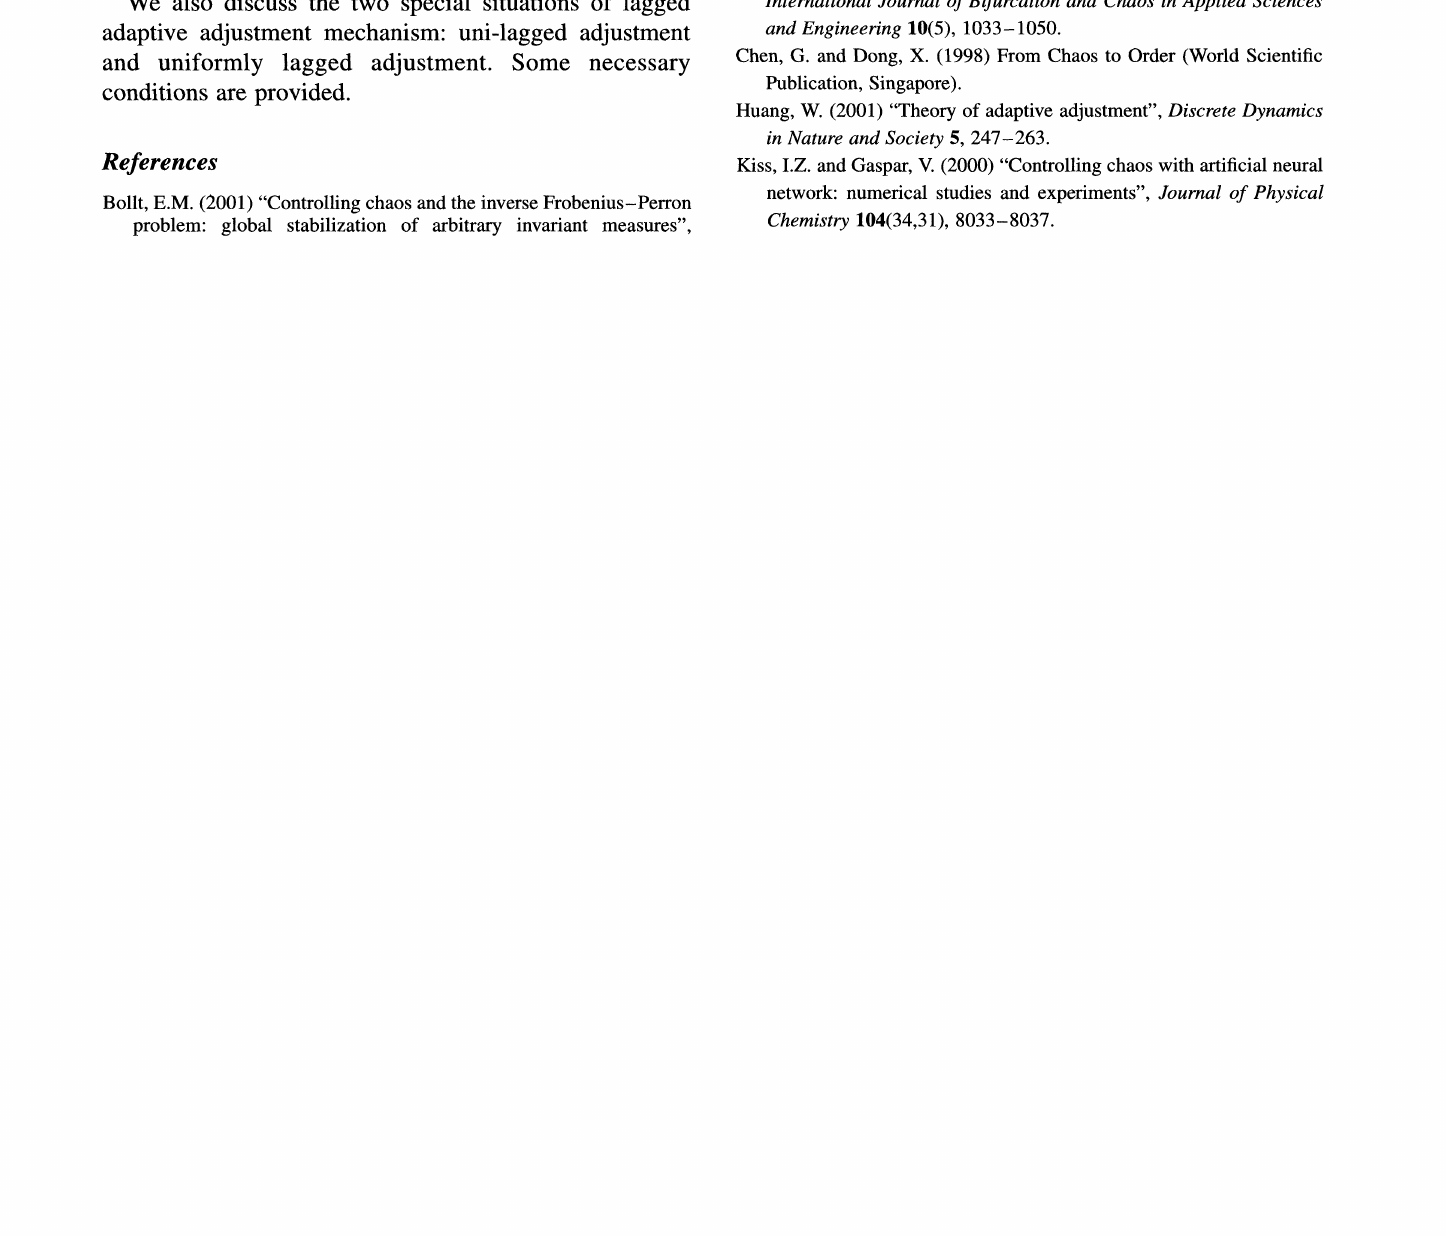
FIGURE 8 Numerical simulations xt ,(xt-1 ,Xt-2,Xt-3),